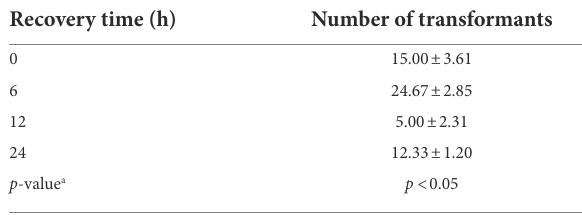
TABLE 2 Effect of time of recovery on the number of transformants (mean ± SE).